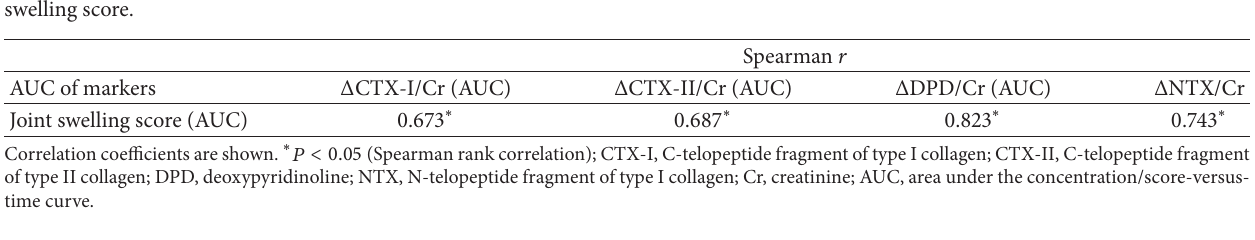
Table 1: Correlations between area under the concentration/score curve of changes in cartilage marker, bone turnover markers, and joint swelling score.